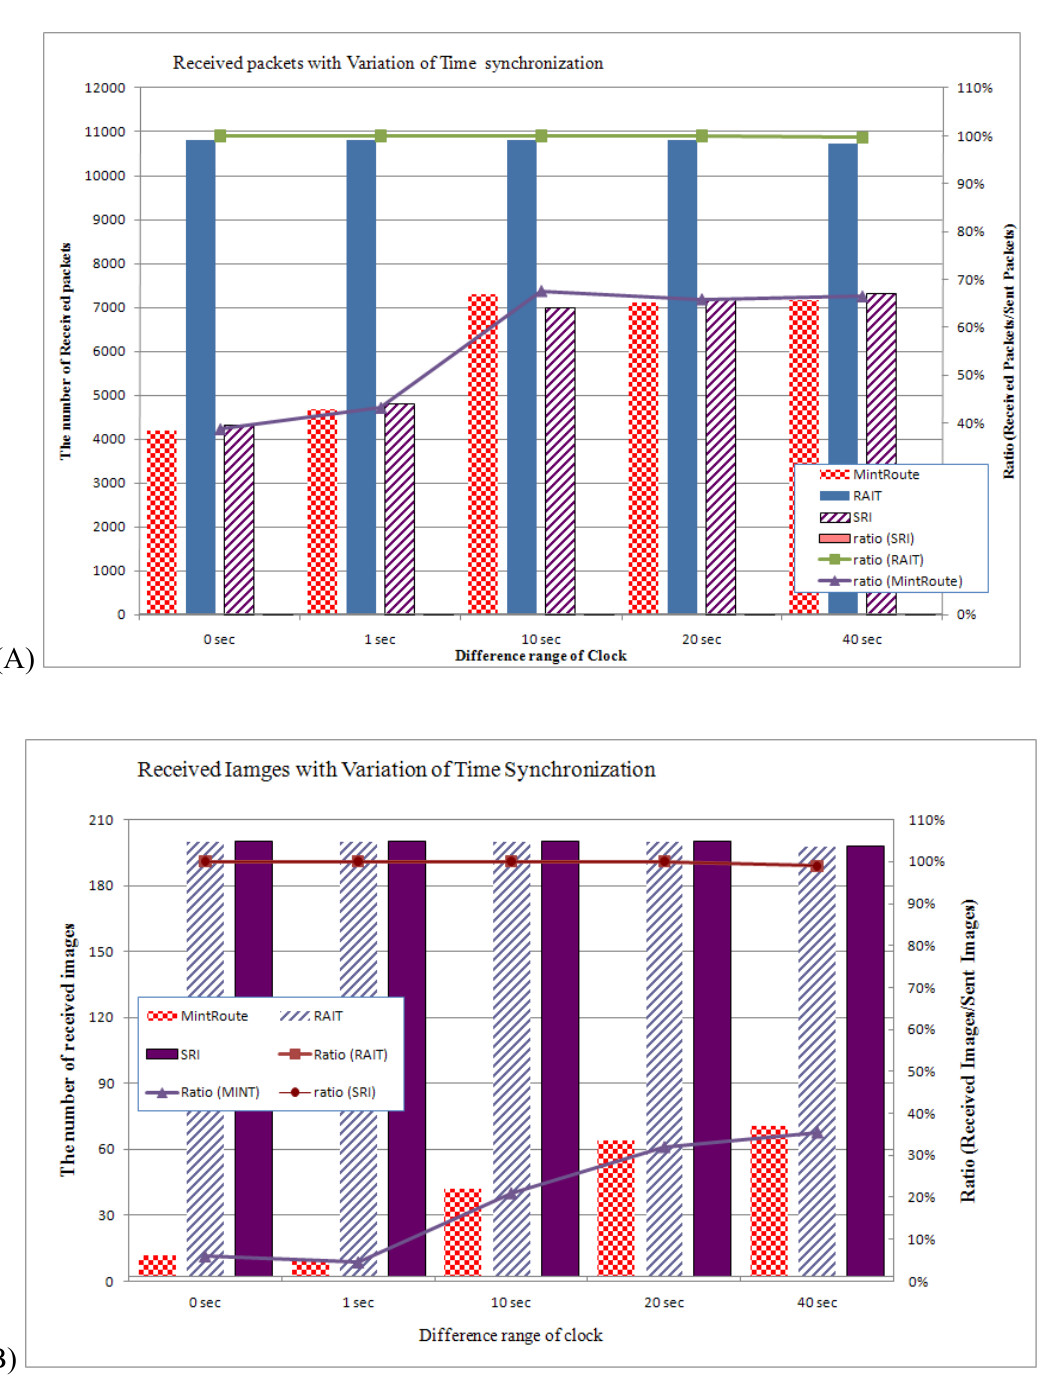
Figure 14. Number of received packets (A) and number of received images (B) with variations in time